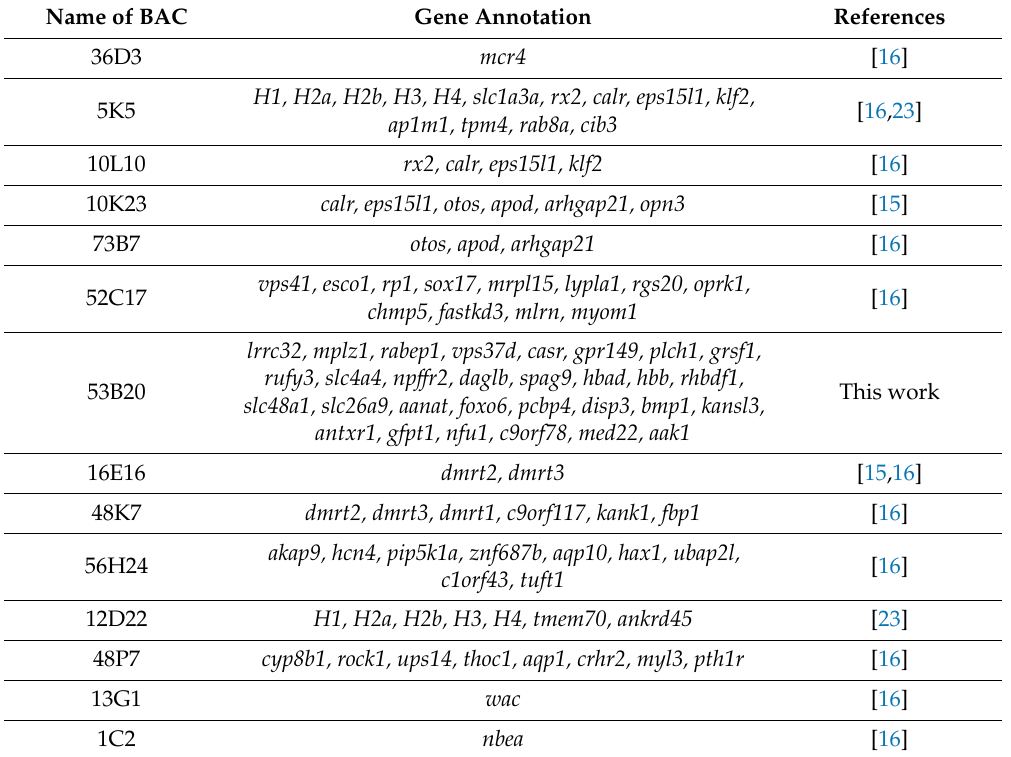
Table 1. BAC clones located on the metacentric chromosome